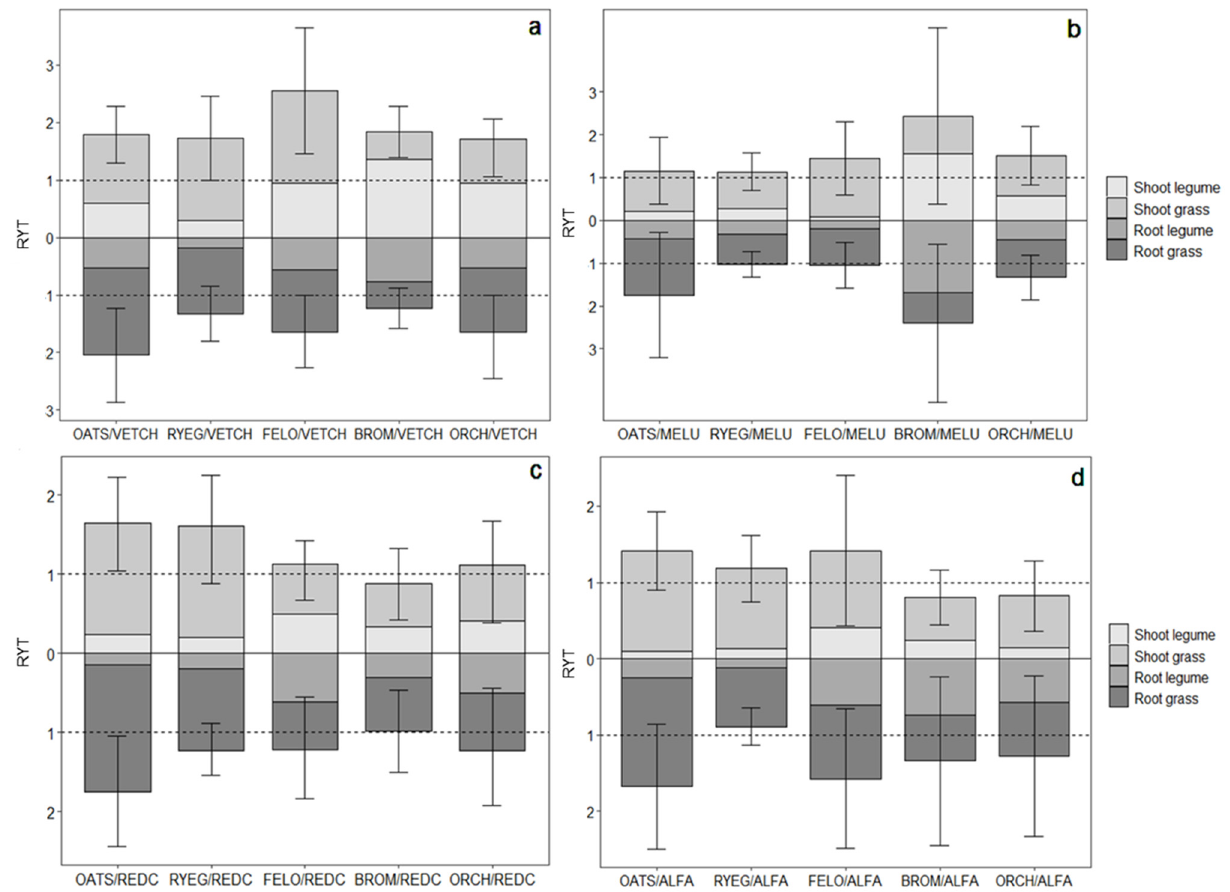
Figure 4. Relative Yield Total (RYT) for each component for above-and belowground biomass pro- duction of mixtures with the four legumes (( a ) Vetch, ( b ) Black medic, ( c ) Red clover, and ( d ) Alfalfa). The light gray box above the “0” line corresponds to the RY of the legume shoot and the dark one corresponds to the grass shoot; likewise, the light gray box below the “0” line corresponds to the legume root and the darker one corresponds to the grass root. The bars represent the 95% confidence interval for the estimated means correspond to the RYT values, noting that all values greater than the overyielding threshold (1.0) correspond to an effective mixture in relation to the monocul ‐ ture.